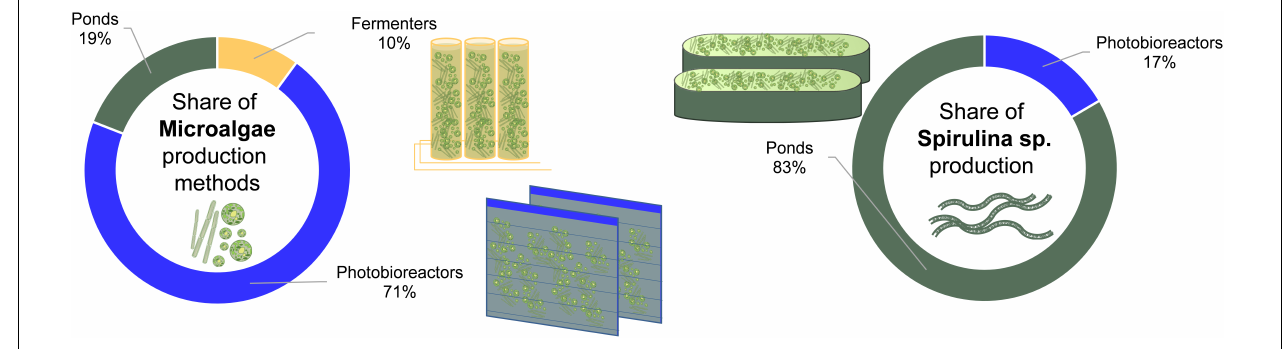
FIGURE 10 | Microalgae and Spirulina share of production methods by production company. The category “Ponds” includes both open and semi-open